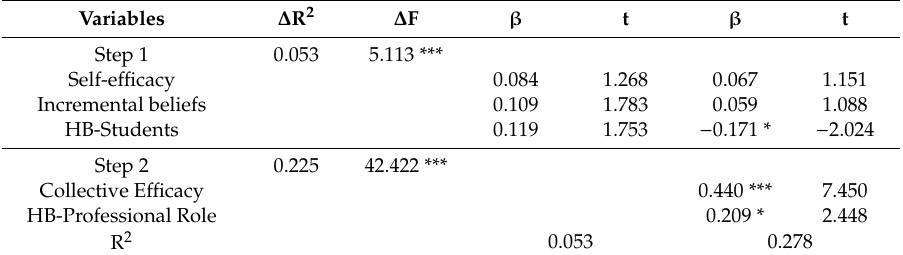
Table 2. Hierarchical regression model: E ff ect of beliefs and emotions related to teachers’ personal experience of school and professional role on job